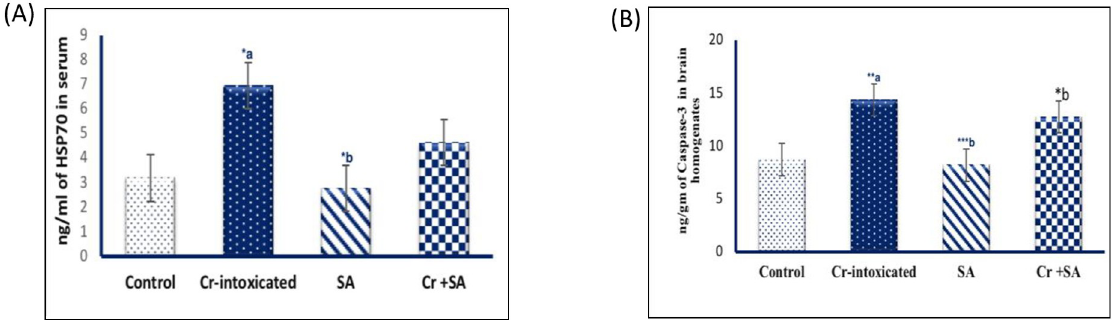
Fig 6. Changes in the level of (A) HSP70, (B) caspase-3 in response to Cr and SA treatments. Results are expressed as mean ± SE (n = 10). � a p � 0 . 05 compared to control group and �� a p � 0.005 compared to control group. � b p � 0.05 compared to Cr group and ��� b p � 0 . 001 compared to Cr